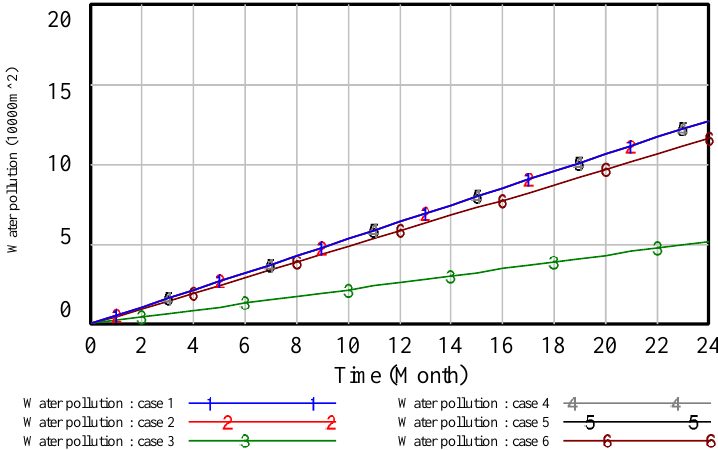
Figure 10. The simulation result of water pollution.